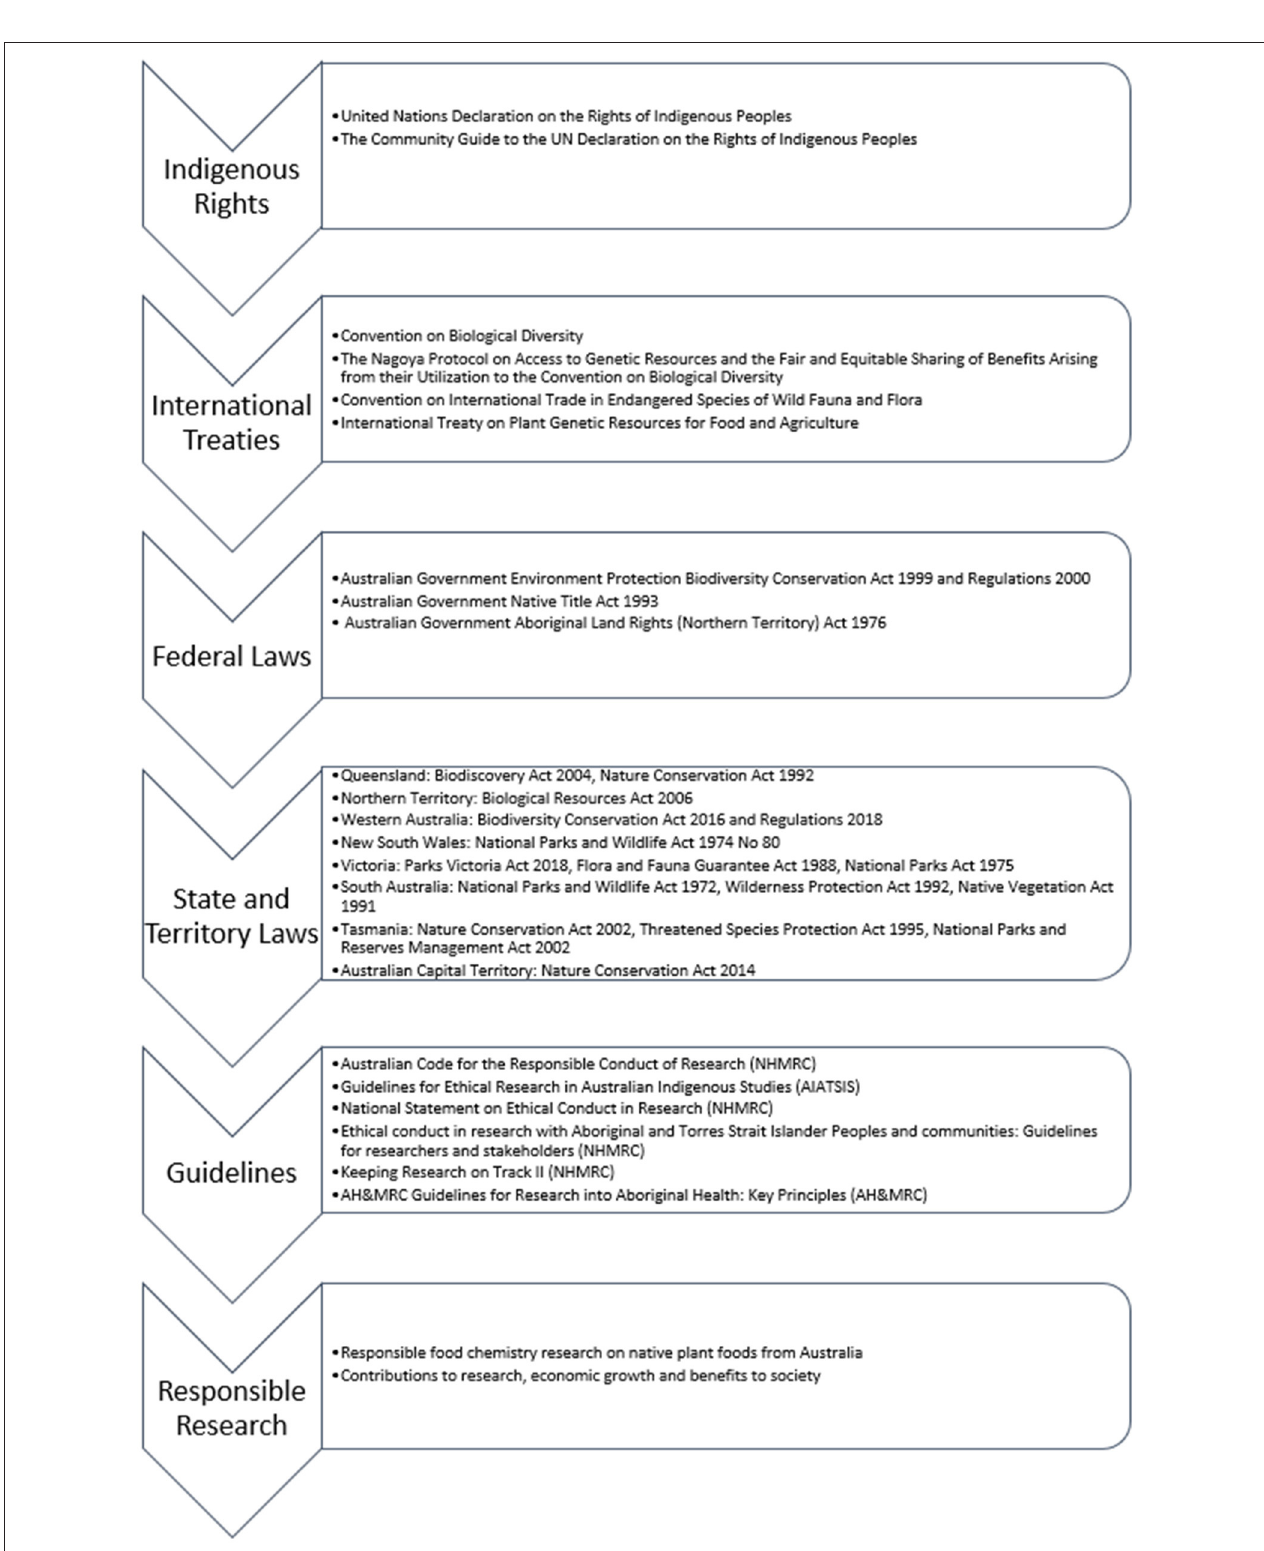
FIGURE 1 | The framework for responsible research for food chemists working with Australian native plant foods. This framework contains key legislation; however, other laws and guidelines may also be relevant.